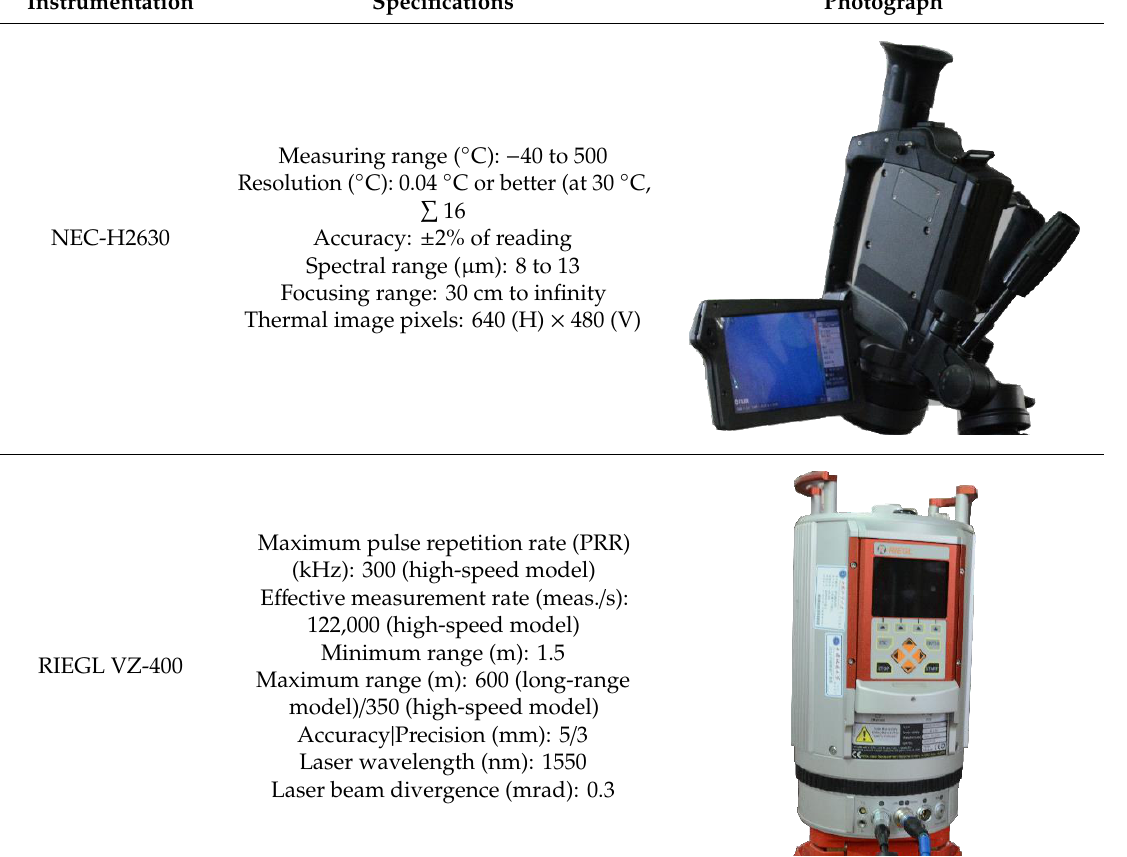
Table 2. Main features of the instrumentation monitoring units.